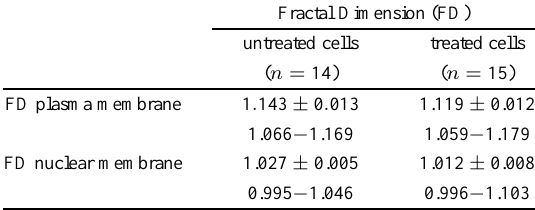
Fractal dimension (FD) of plasma and nuclear membrane outlines in SK-BR-3 cells, untreated (control) and treated with 1 µ M calcimycin for 24 h. Results are median values ± standard error on the median. Ranges of values are in the lower row. No significant difference between untreated and treated cells. n : number of examined cells